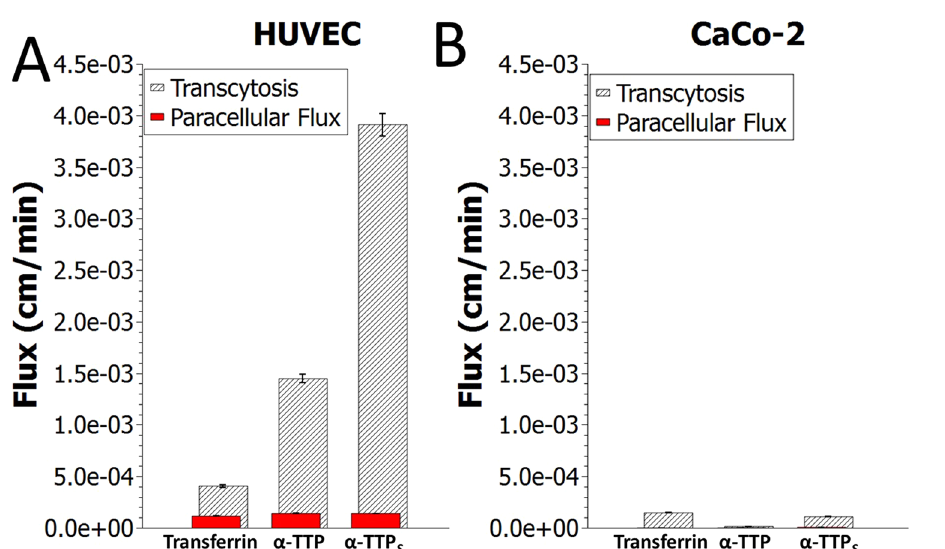
Figure 5. ( A ) Flux-rates of transcytosis across a human umbilical vein endothelial cell (HUVEC) monolayer. ( B ) Flux-rates of transcytosis across a heterogeneous human epithelial colorectal adenocarcinoma cell (Caco-2) monolayer. Three independent experiments were performed within each cell line; n = 3,